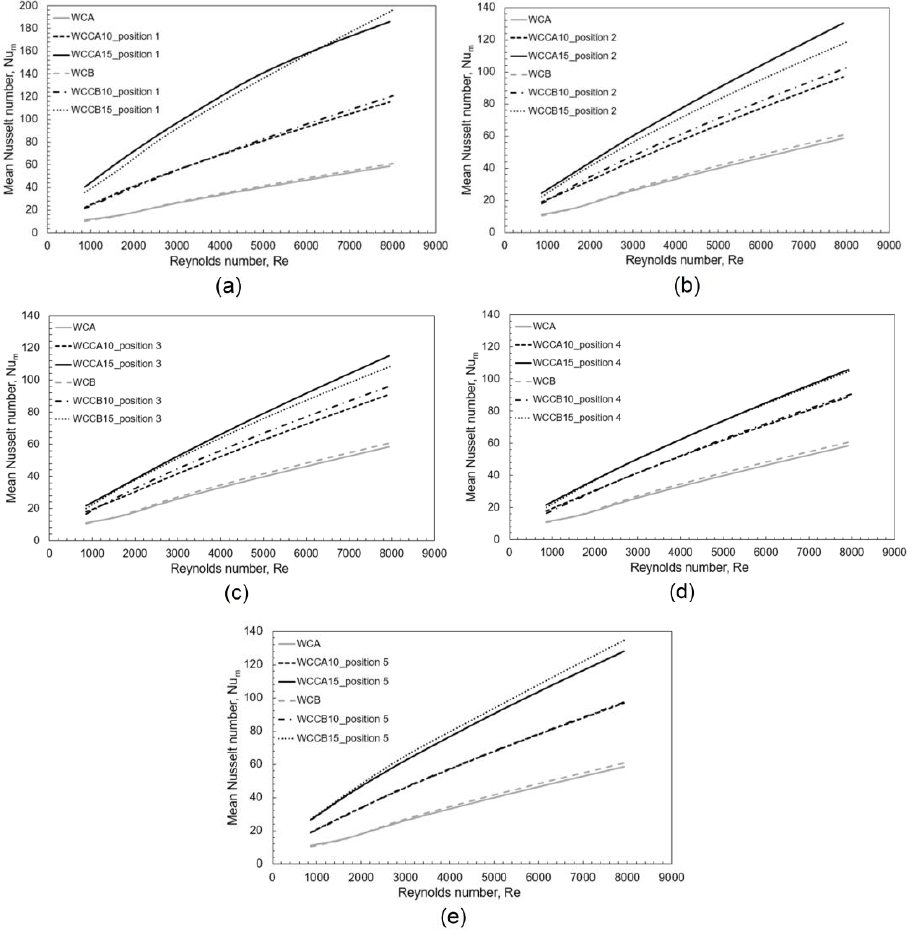
Figure 8. The effect of configuration and position of CVGs on the mean Nusselt number when changing the Reynolds number, ( a ) WC vs. WCC at the position ‘1’, ( b ) WC vs. WCC at the position ‘2’, ( c ) WC vs. WCC at the position ‘3’, ( d ) WC vs. WCC at the position ‘4’, ( e ) WC vs. WCC at the position ‘5’.